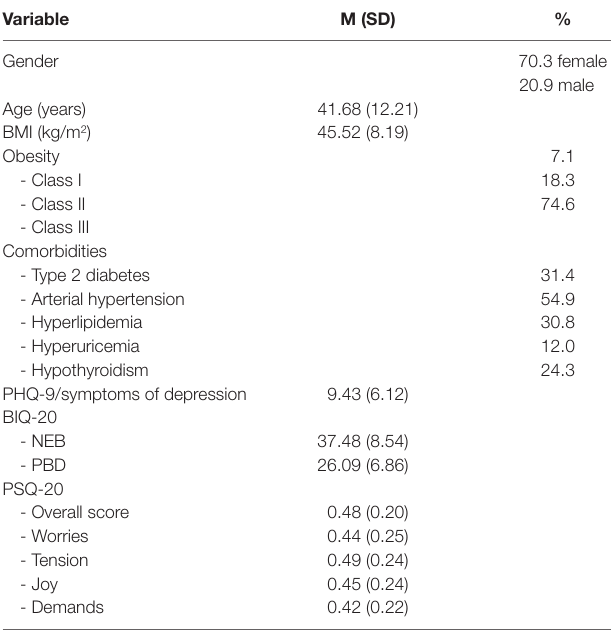
TaBle 1 | Demographic characteristics of the study population (N = 579).